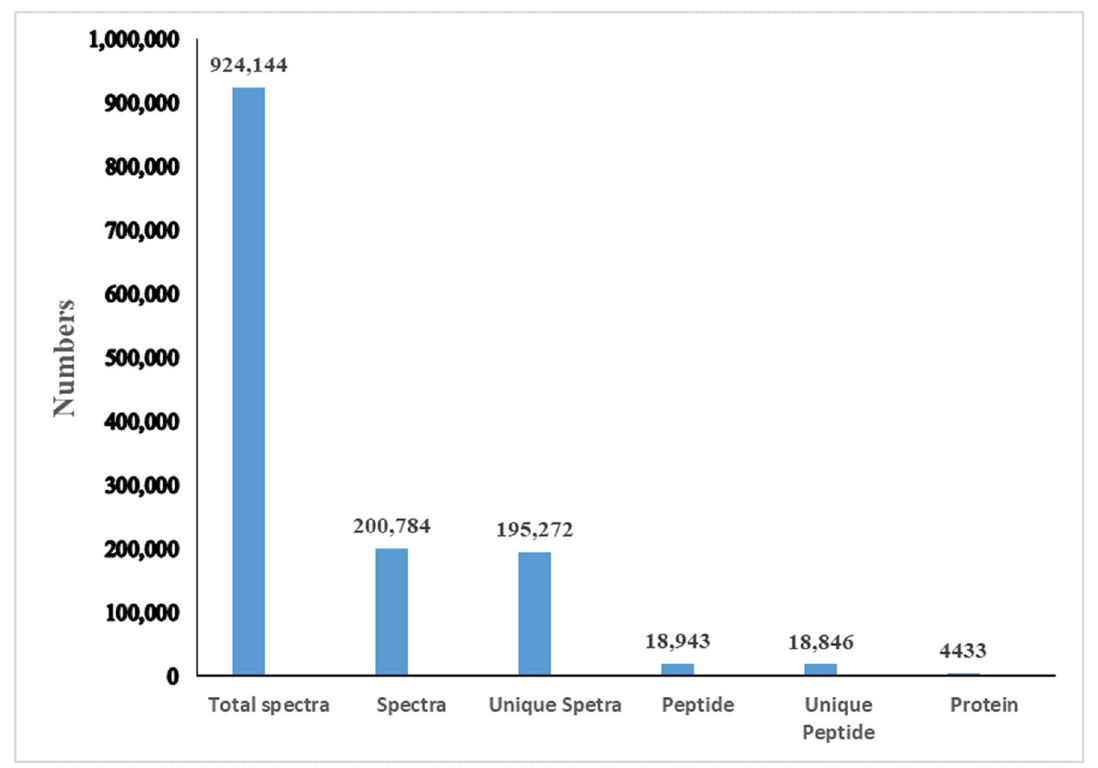
Figure 1. Summary of the proteome profile in P. trituberculatus hemocytes by iTRAQ. “Total spectra” are the secondary mass spectra, and “Spectra” are the secondary mass spectra after quality control. “Unique Peptide” is the identified peptides that belong only to a group of proteins.